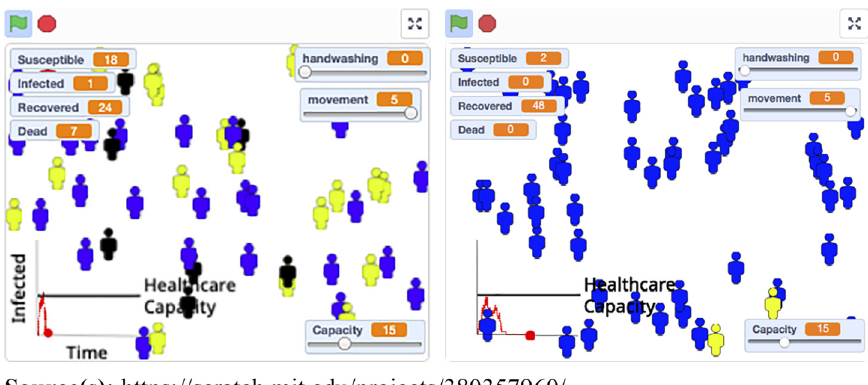
Figure 11. Infectious disease simulator with healthcare